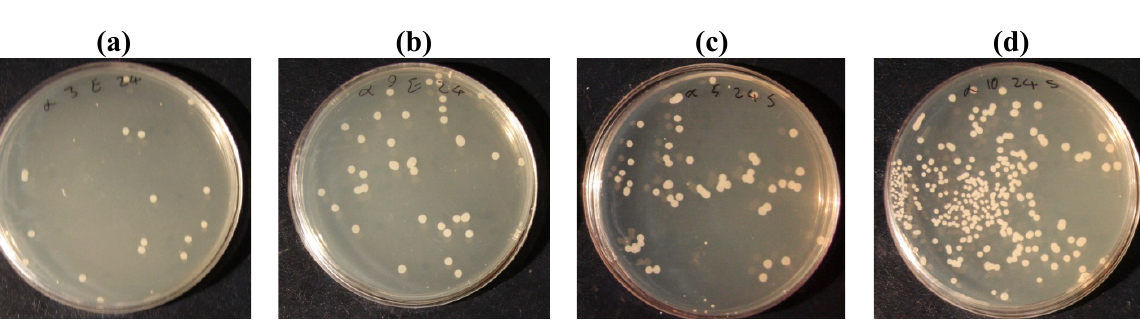
Figure 3. The bacteria colonies of silver nanoparticles coating on laser treated cotton ( a ) Coli before laundering; ( b ) Coli after laundering;